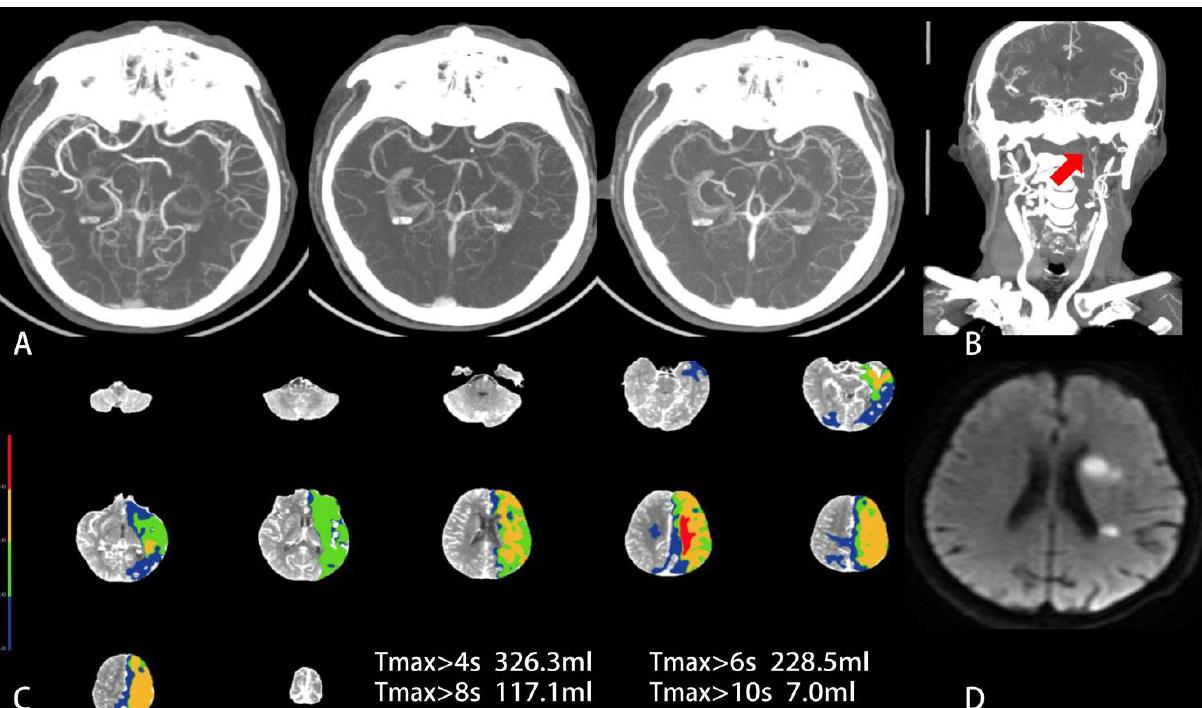
Figure 2. Baseline mCTA, CTP and follow-up DWI in a 70-year-old man with wake-up stroke. The time from last known well to CT scan was 12.5 h. The baseline NIHSS score was 7 and the ASPECTS score on NCCT was 7. ( A ) mCTA axial MIP shows robust pial collateral vessels within the left temporal parietal lobe and only a one-phase delay in the filling of peripheral vessels. The mCTA collateral score was 4 (favorable collateral status). ( B ) Coronal reconstruction of neck CTA MIP shows severe stenosis/occlusion of C1–4 segment of left internal carotid artery (red arrow). ( C ) Tmax map shows the severe hypoperfusion area (red) defined Tmax > 10 s was 7 mL and a hypoperfusion area (light green) defined Tmax > 6 s was 228.5 mL, while HIR (=0.03) was very low. ( D ) This patient underwent a successfully EVT and had a FIV of 8.6 mL on the left basal ganglia and paraventricular region on DWI. The 90 d mRs score of this patient was 2 (favorable functional